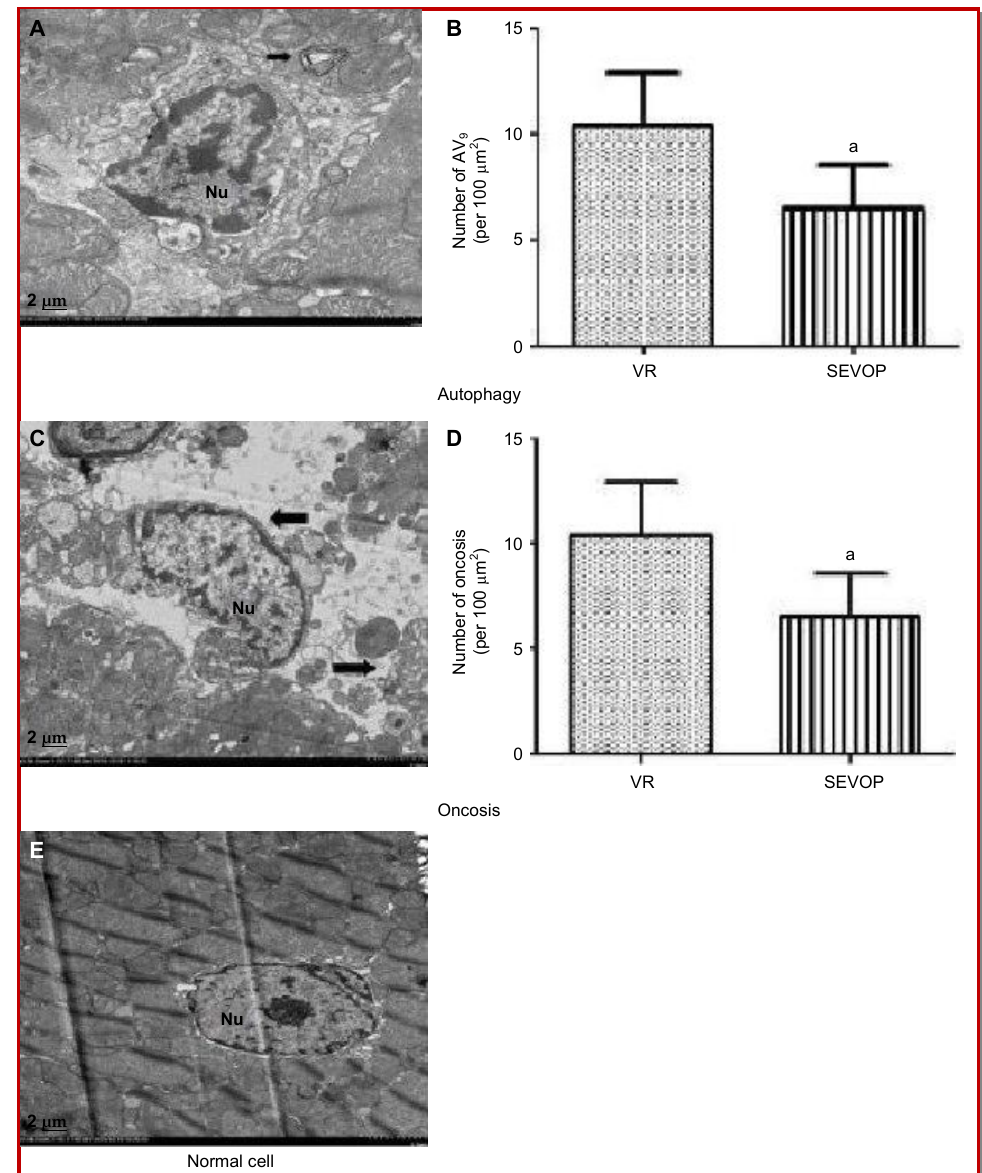
Figure 2: Autophagic vacuoles, oncotic cells, and normal cells in rat heart in the I/R group under a transmission electron micro- scope (A) Autophagic vacuoles are a vesicular structure with a double-layer or single-layer membrane, cytoplasm, and organelle components (×2000 mag- nification, bar=2 am, shown by the arrow). (B) Comparison of the numbers of autophagic vacuoles between the two groups. (C) Oncosis results in cell swelling, increased volume, cytoplasmic vacuoles, endoplasmic reticulum swelling, significant reduction of cristae, and formation of electronic transparent areas. (D) Comparison of the numbers of oncotic cells. (E) Cells in the sevoflurane preconditioning group. Autophagic vacuoles and oncotic cells in all groups were quantitatively analyzed. After one-way analysis of variance, the Student-Newman-Keels method was used to com- pare the mean values among multiple samples (n = 5). The results were presented as the mean ± standard deviation. a p<0.05 indicated statistical significance. Sham: Sham surgery group; IR group: Ischemia-reperfusion group; SEVOP group: Sevoflurane postconditioning in the myocardial ischemia- reperfusion group. AVs, autophagic vacuoles; Oncosis: Oncotic